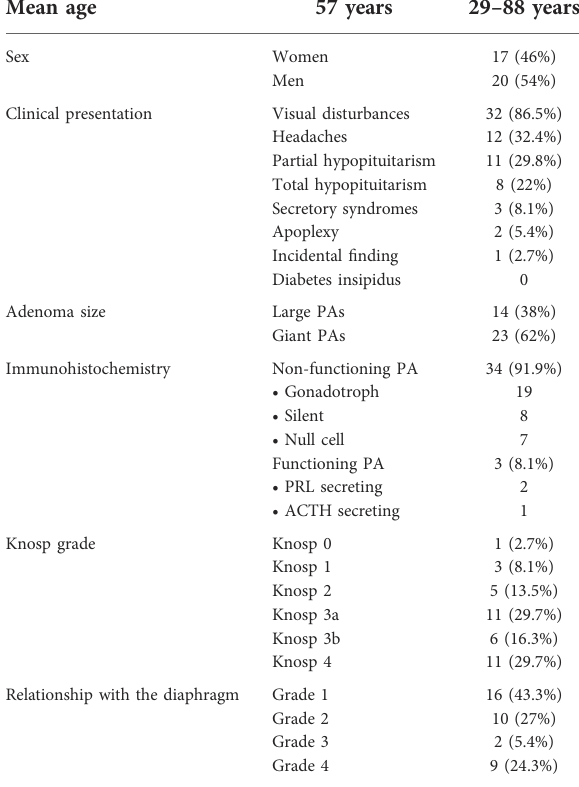
TABLE 1 Detailed clinical, pathological, and radiological data.